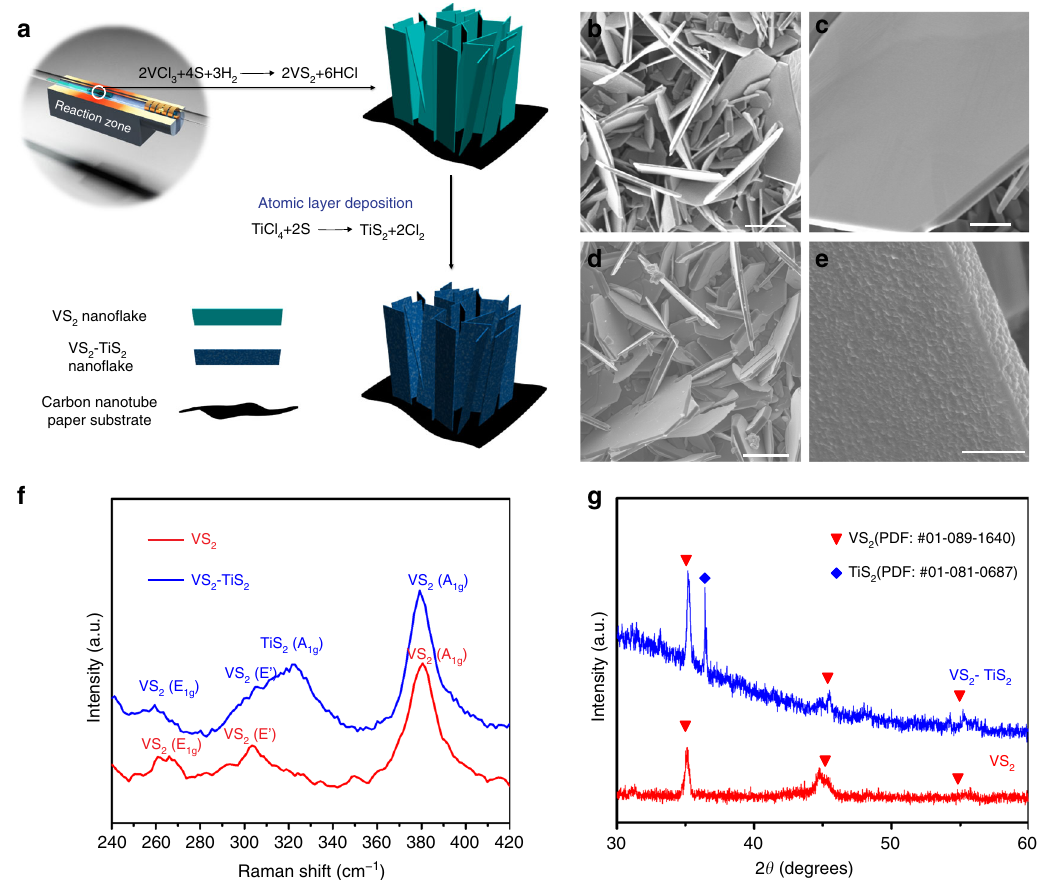
Fig. 1 Synthesis and characterization of VS 2 and VS 2 -TiS 2 fl akes. a Schematic of the procedure for fabricating VS 2 and VS 2 -TiS 2 composites. b , c Top-view SEM ( b : scale bar = 10 μ m; c : scale bar = 3 μ m) of VS 2 fl akes with different magni fi cation. d , e Top-view SEM ( d : scale bar = 10 μ m; e : scale bar = 1 μ m) of the VS 2 -TiS 2 structures with different magni fi cation. f Raman spectrum of VS 2 and VS 2 -TiS 2 . g X-ray diffraction pattern of VS 2 and VS 2 -TiS 2 fl